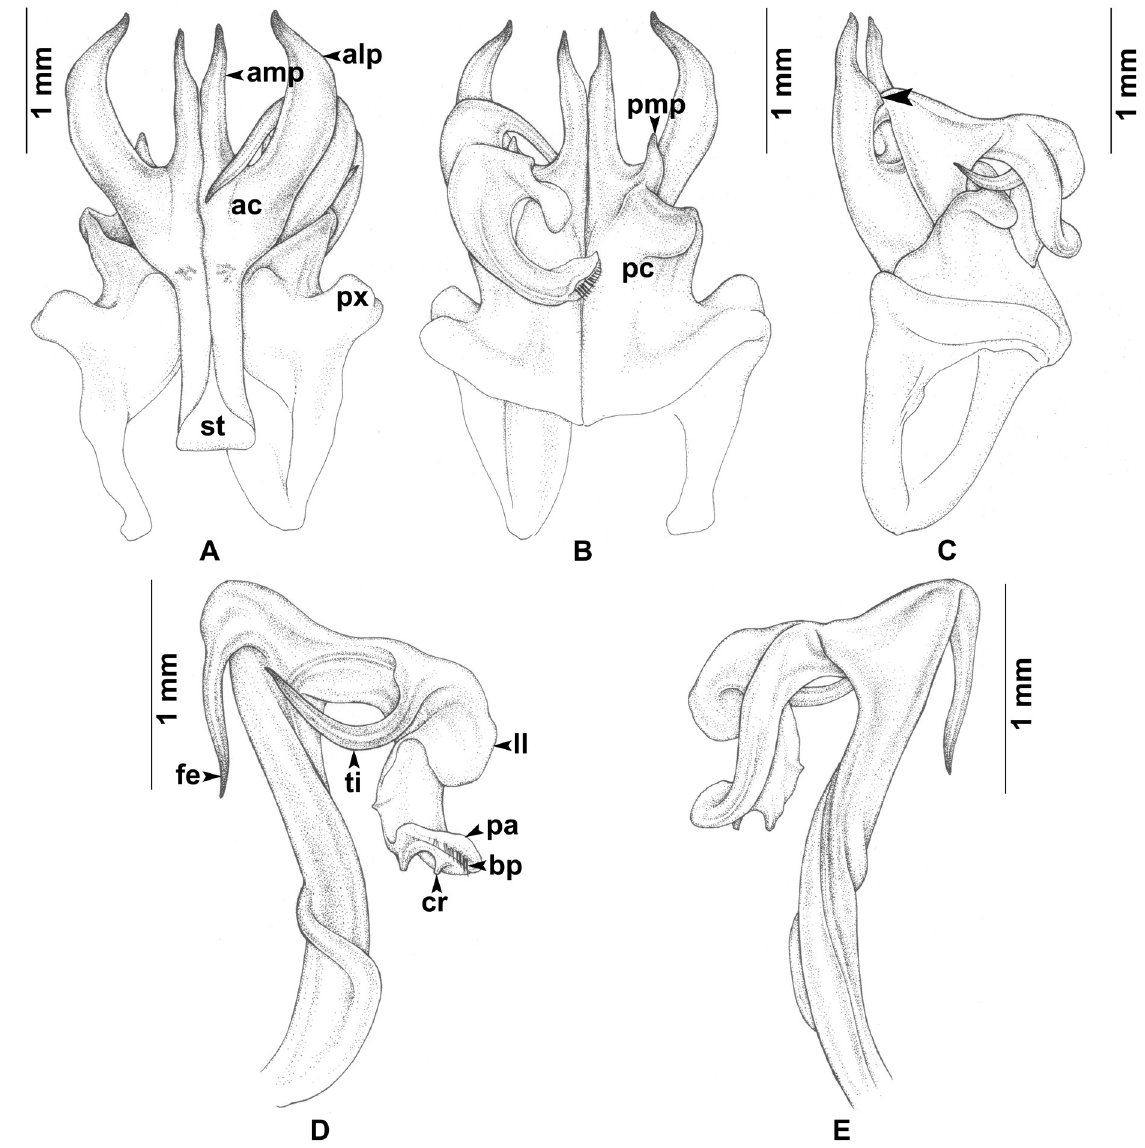
Fig. 2. Thyropygus cimi sp. nov., from Namwang Srithammasokrach, holotype (CUMZ-D00086), ♂, gonopods. A . Anterior view, left telopodite removed. B . Posterior view, left telopodite removed. C . Lateral view. D . Left telopodite, posterior-mesal view. E . Left telopodite, anterior-lateral